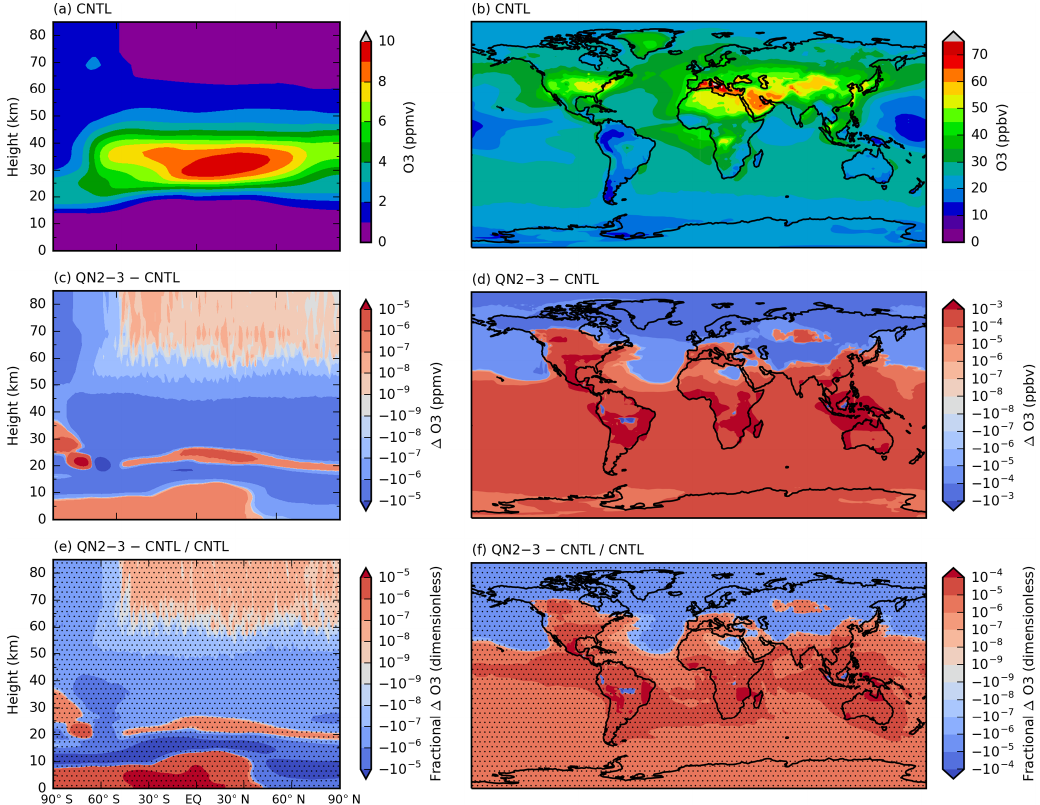
Figure 7. (a, c, e) Zonal-mean ozone from the last 10 years of the 20-year StratTrop 432-core simulations and (b, d, f) surface ozone from the last 10 years of the 20-year StratTrop 432-core simulations. (a, b) Ozone from the CNTL simulation. (c, d) Absolute differences between the QN2–3 simulation and the CNTL simulation. (e, f) Fractional differences between the QN2–3 simulation and the CNTL simulation. Stippling in the (e) and (f) plots indicates that the values are below the convergence criterion of the chemical solver (10 − 4 ). Table 7. Comparison of Newton–Raphson versus quasi-Newton methods by the metrics NMAD and NRMSD. Chemistry